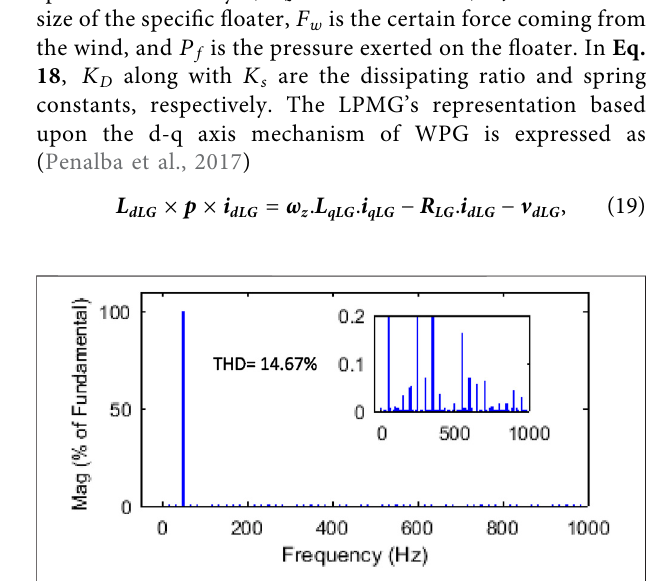
FIGURE 4 | FFT window for RL load